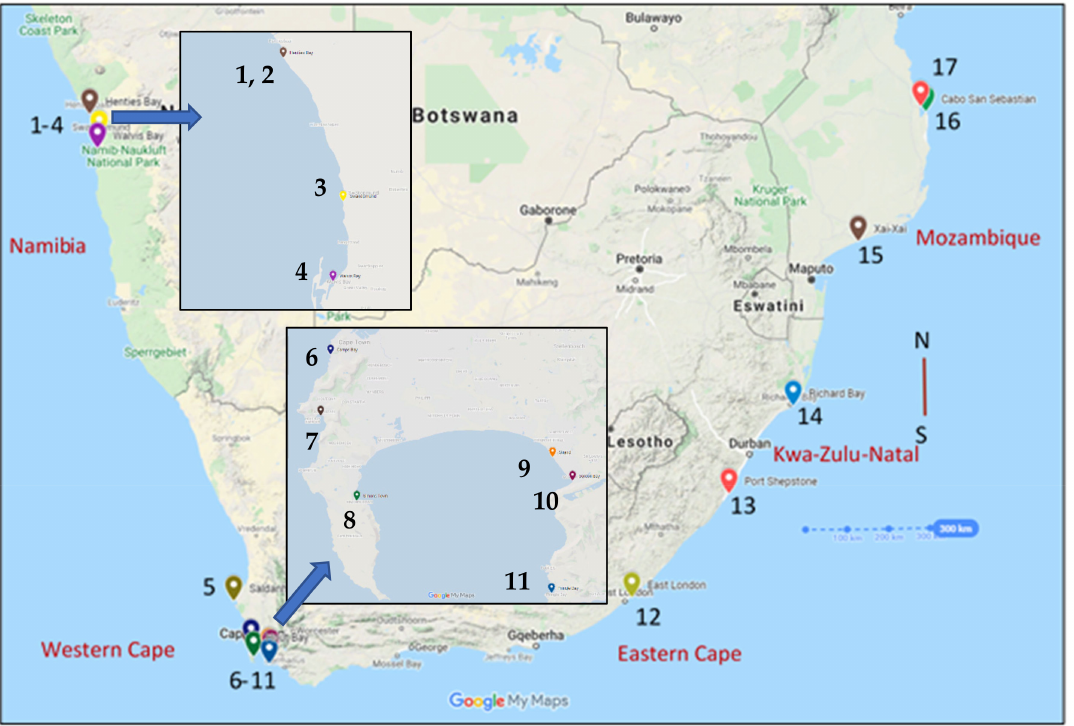
Figure 1. Sampling sites along the south coast of